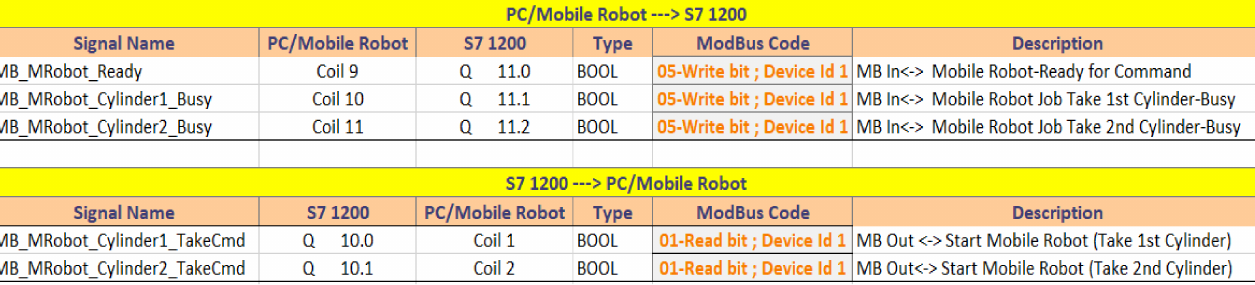
Figure 15. Modbus message interface (Modbus Map).